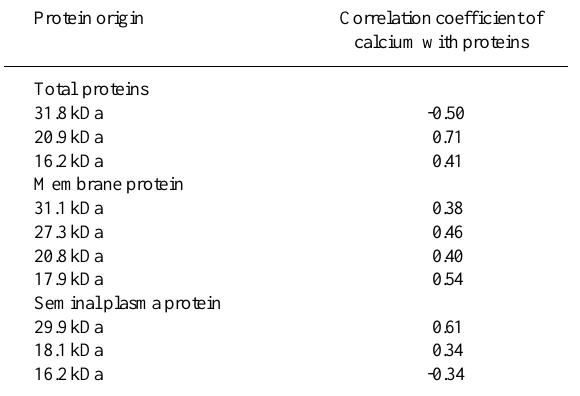
Table II - Correlation coefficient between semen proteins and calcium concentration in bovine seminal plasma. Protein origin